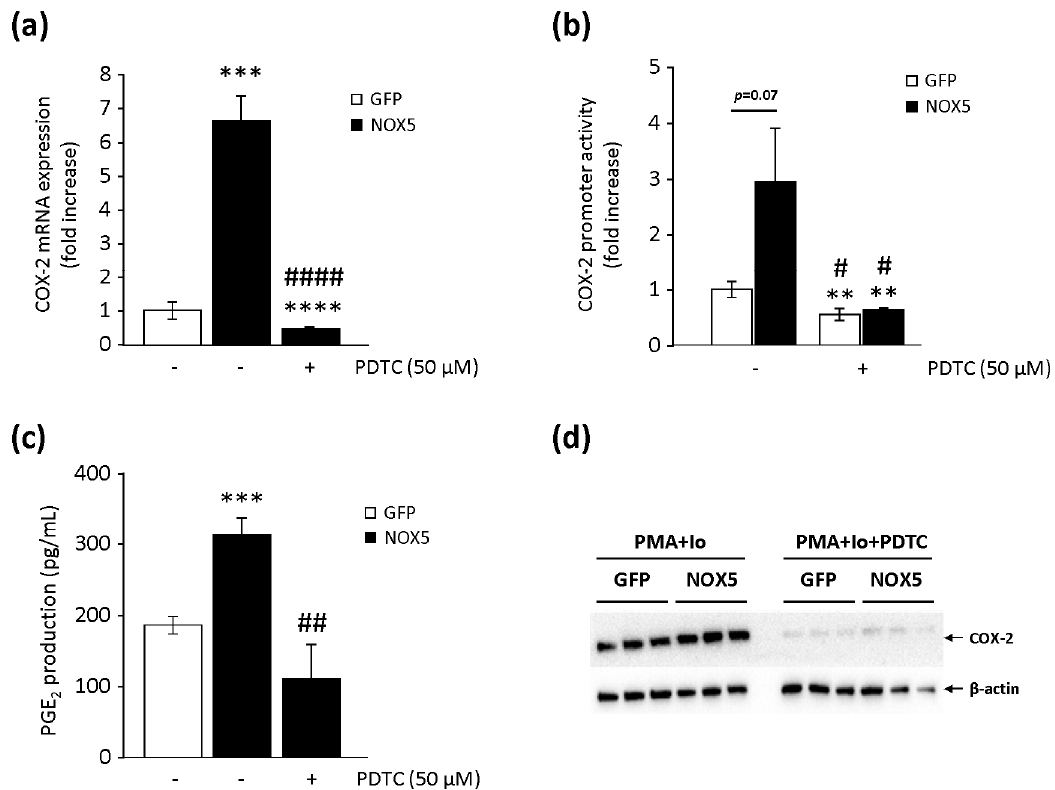
Figure 6. Role of nuclear factor kappa-light-chain-enhancer of activated B cells (NF- κ B) in the NOX5 / COX-2 axis in TeloHAEC. ( a ) COX-2 mRNA levels of NOX5- β - and GFP-infected cells for 12 h